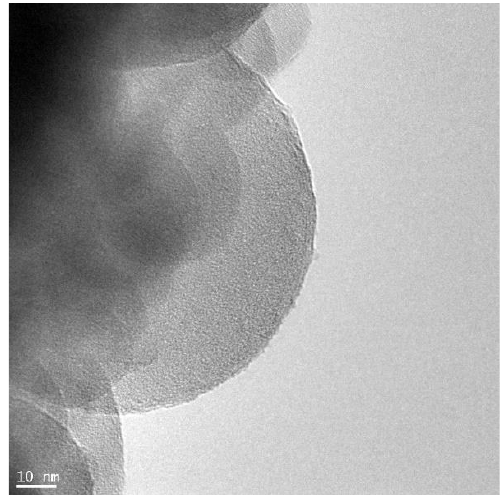
Figure 1 . TEM images of nano-silica (NS) [14]. Figure 1. TEM images of nano-silica (NS) [14].